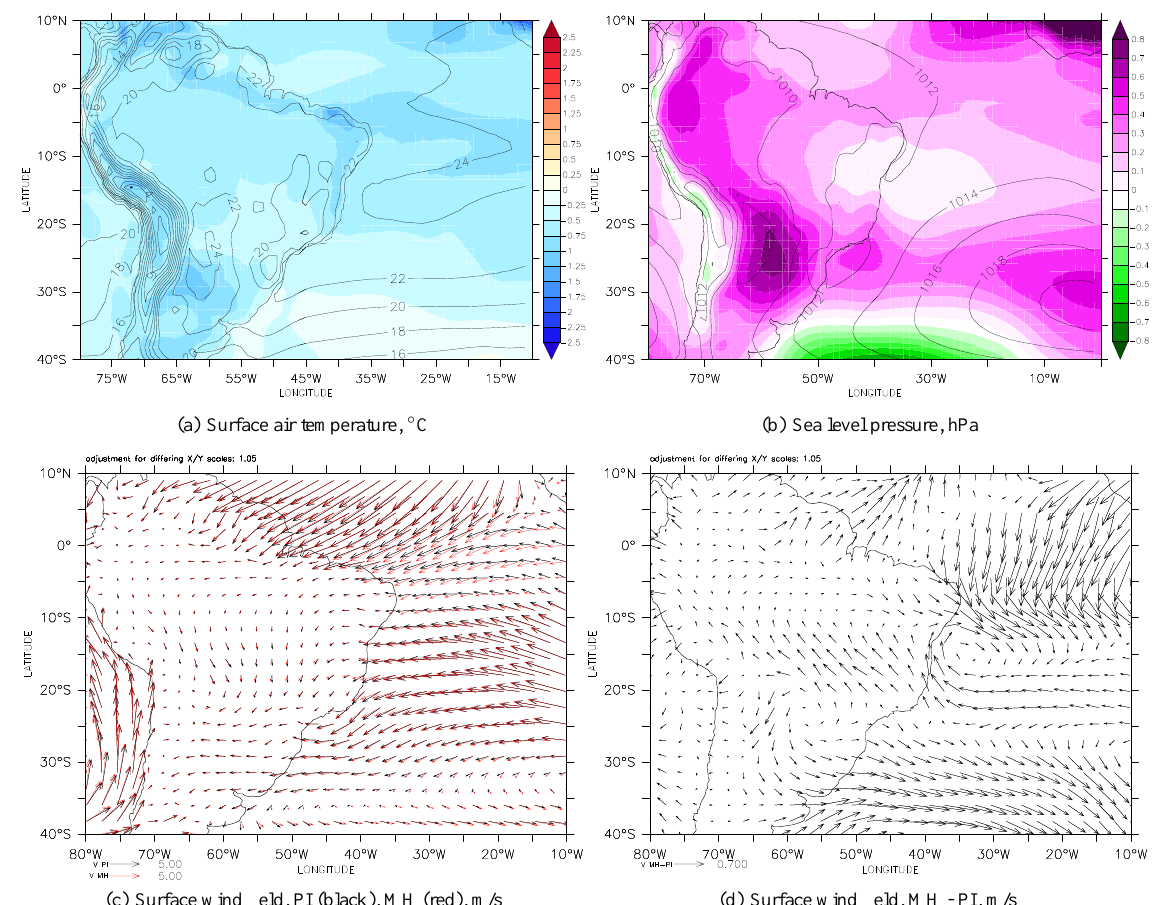
Fig. 13. MH - PI difference in JFM surface air temperature (a, ◦ C) and sea level pressure (b, hPa); contours are PI values, colours indicate differences between MH and PI. (c) shows the PI surface wind field (black) and the MH surface wind field (red), unit length is 5.0 m/s, (d) gives the difference between the MH and PI wind field, unit length is 0.7 m/s. These are JFM averages; note that the scales of the colour bars and vectors are not the same as in Figures 7 and 9